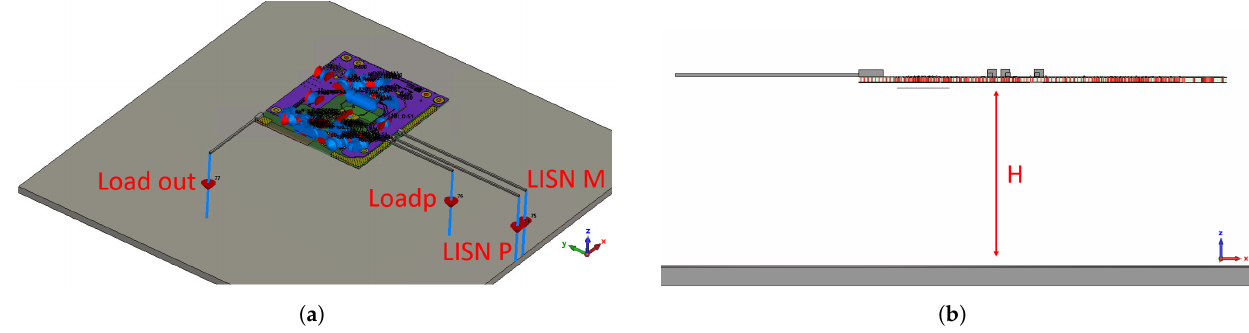
Figure 8. Three-dimensional model of the complete test setup including the test PCB, the metal reference table with a distance of H = 50 mm, and the supply cables. The LISN networks are connected to LISN M/P, and the load is connected between Load out and Loadp. ( a ) top view; ( b ) front